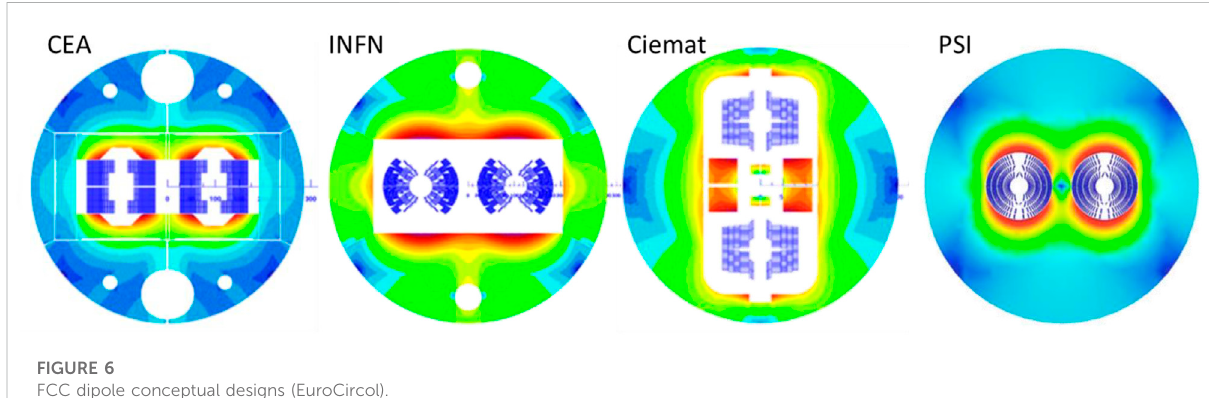
FIGURE 6 FCC dipole conceptual designs